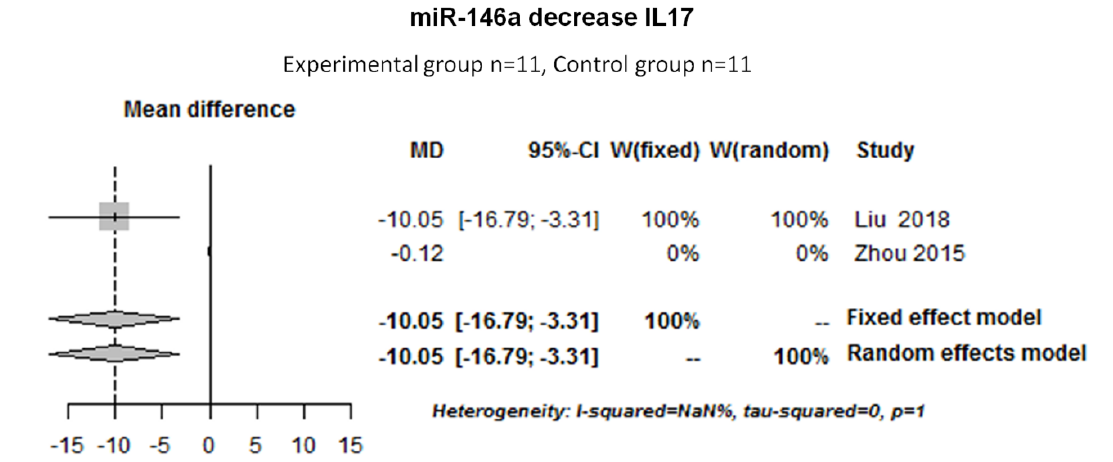
Figure 4. Forest plot of the meta-analysis for the effect of miR-146a on IL-17 in human cell cultures (SF, T cell). NaN: Not a number.